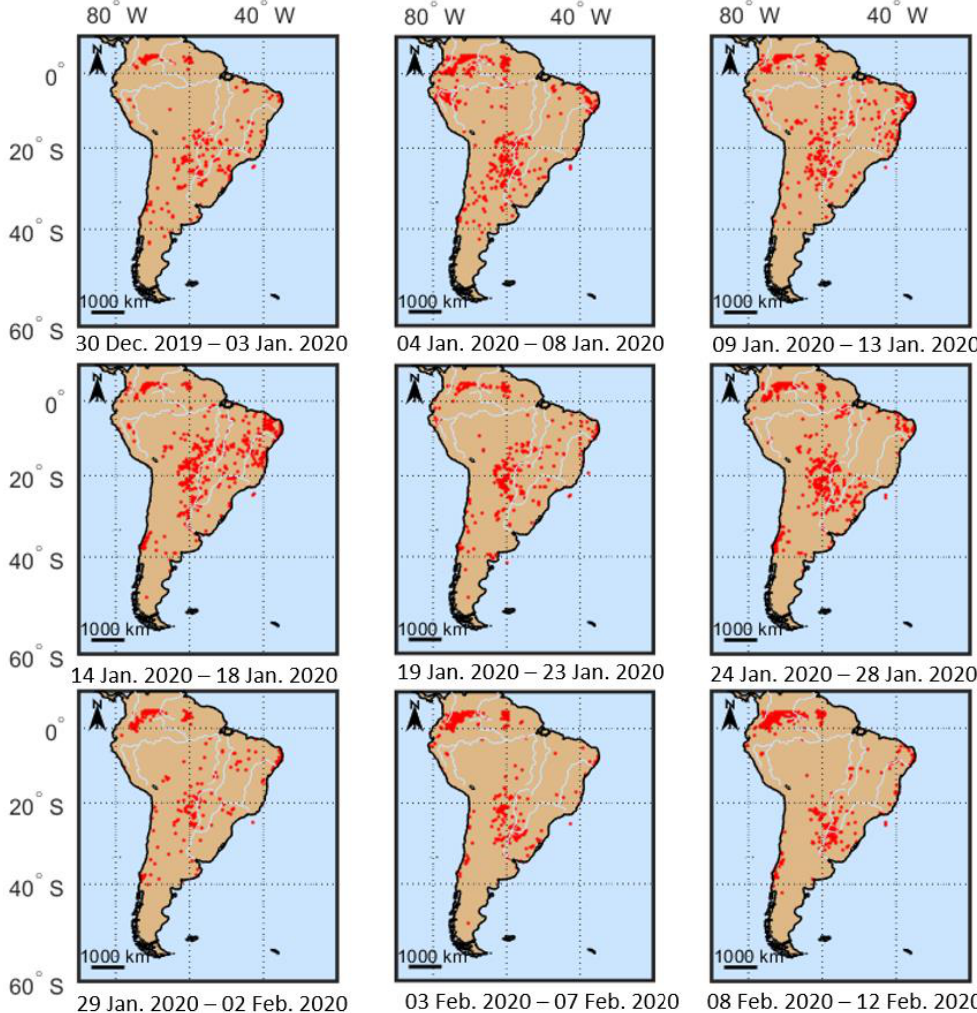
Figure A1. Active fires in South America, as obtained by MODIS for the time period of December 2019 – February 2020; the confidence of the fire spots was set to be above 70%. Table A1. Mean values and std of the relative change of CO and Ο 3 as they were calculated per re- gion and pressure level of the study area.